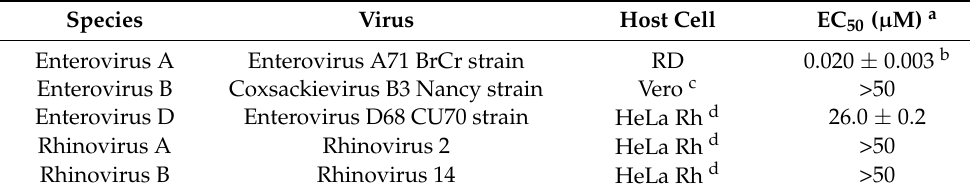
Table 3. Evaluation of 23 ( AL-534 ) against a representative panel of enteroviruses.